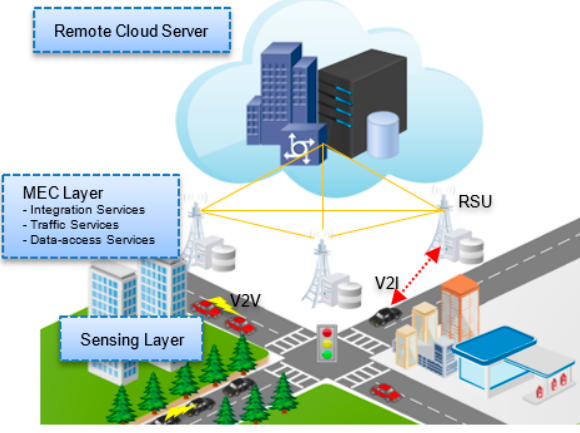
Figure 1. The VEC Architecture.